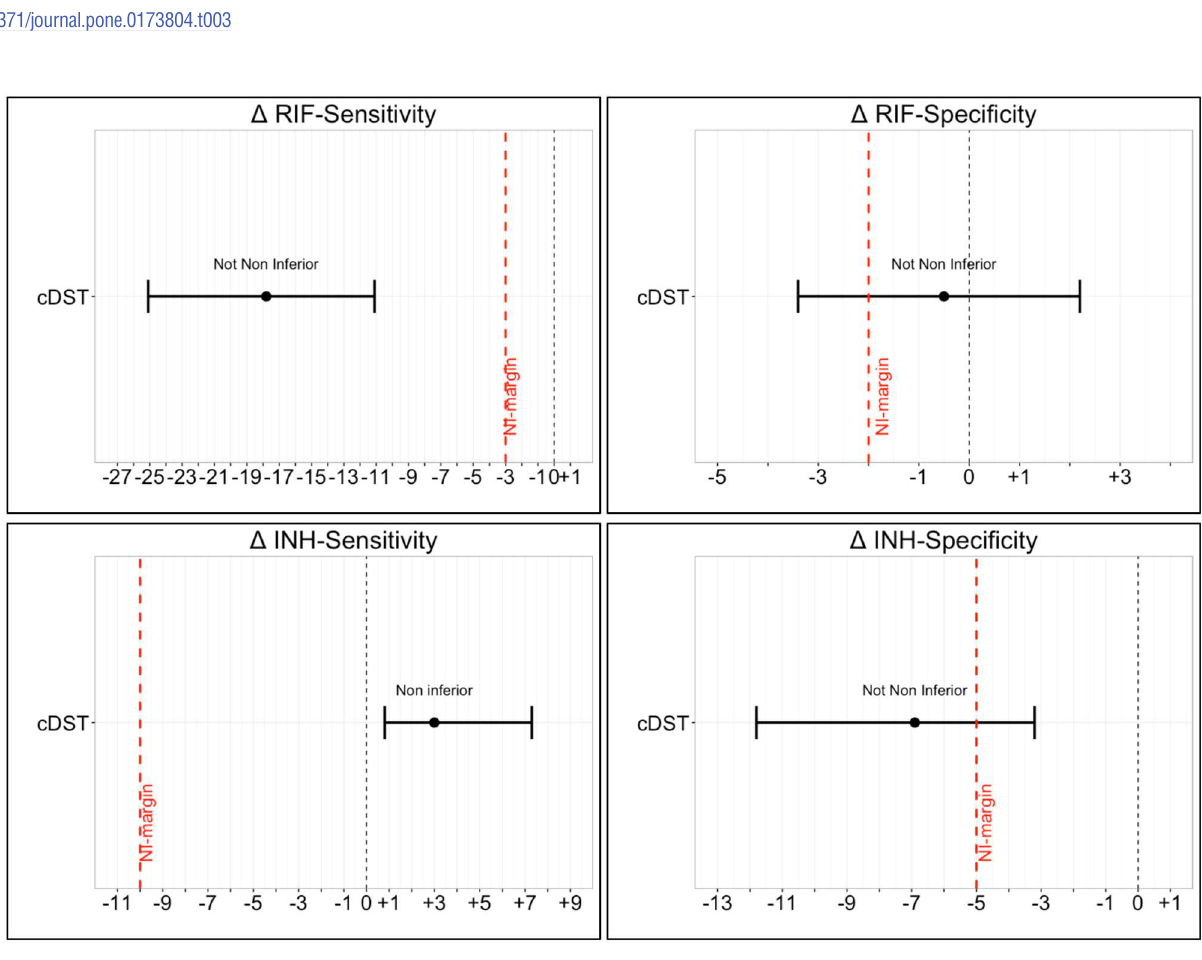
Fig 1. Phase 1 comparative accuracyof the YD line probe assay versus Hain V1 line probe assayon characterized strains. The difference in sensitivity/specificity ( Δ = YD–HainV1) is displayedtogether with the CIs for the difference in each plot. The horizontalaxis indicatesthe percentagedifference betweentests. The point in the center of each CI represents the point estimate and whiskers representingthe upper and lower limit of the 95% CIs. The black vertical dotted line (where visible)indicates zero difference in sensitivity/ specificity and the red vertical broken line indicatesthe non-inferiority margin. Non-inferiority is demonstrated for a given comparisonif the lower limit of the 95%CI does not cross the